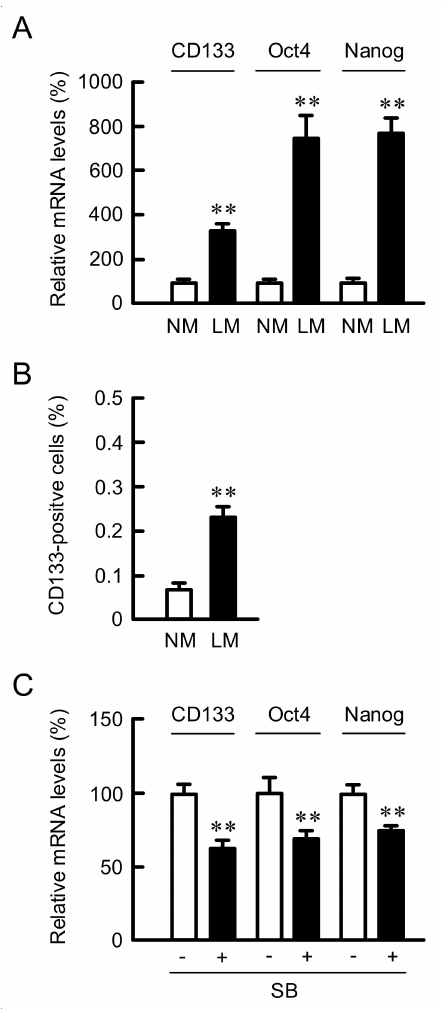
Figure 8. Increase in proportion of CSLCs by LM. A549 cells were continuously cultured in the media containing NM or LM. ( A ) Real-time PCR was performed using primer pairs for CD133, Oct4, Nanog, and β -actin. The mRNA levels are represented in percentage to LM. ( B ) The cells were stained with PE-conjugated anti-CD133 antibody. The percentages of CD133-positive cells were measured using a Muse Cell Analyzer. ( C ) A549 cells cultured with LM were incubated in the absence and presence of 10 µ M SB203580 (SB) for 6 h. Real-time PCR was performed using primer pairs for CD133, Oct4, Nanog, and β -actin. The mRNA levels are represented in percentage to the cells without SB. n = 4. ** p < 0.01 compared with